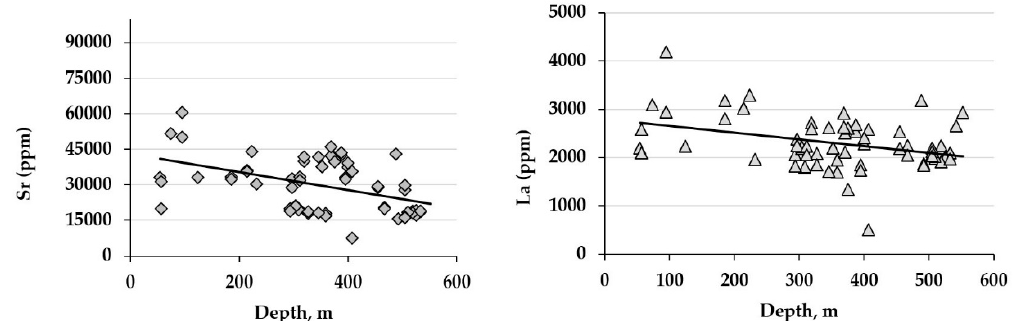
Figure 4. Distribution of Sr, La in apatite in the vertical section of Rasvumchorr deposit.